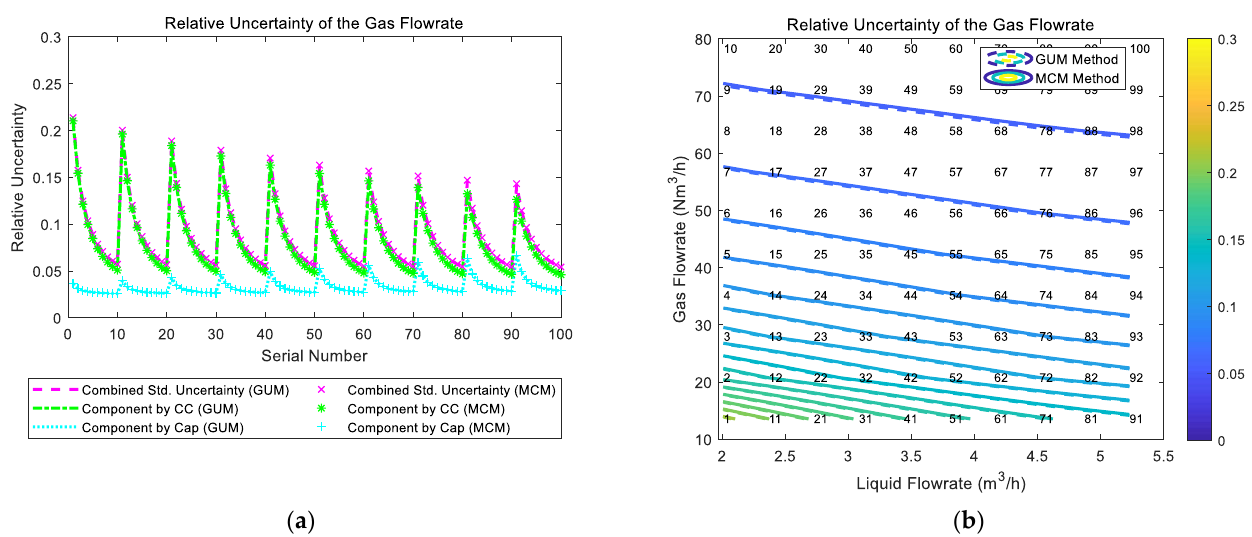
Figure 7. The composition and distribution of the relative uncertainty of the gas flowrate of the “Cap + CC” method: ( a ) composition diagram; ( b ) distribution diagram. (Each contour line denotes an increment of uncertainty of 0.01. More information about the composition and distribution can be found in Section 2.4.1).